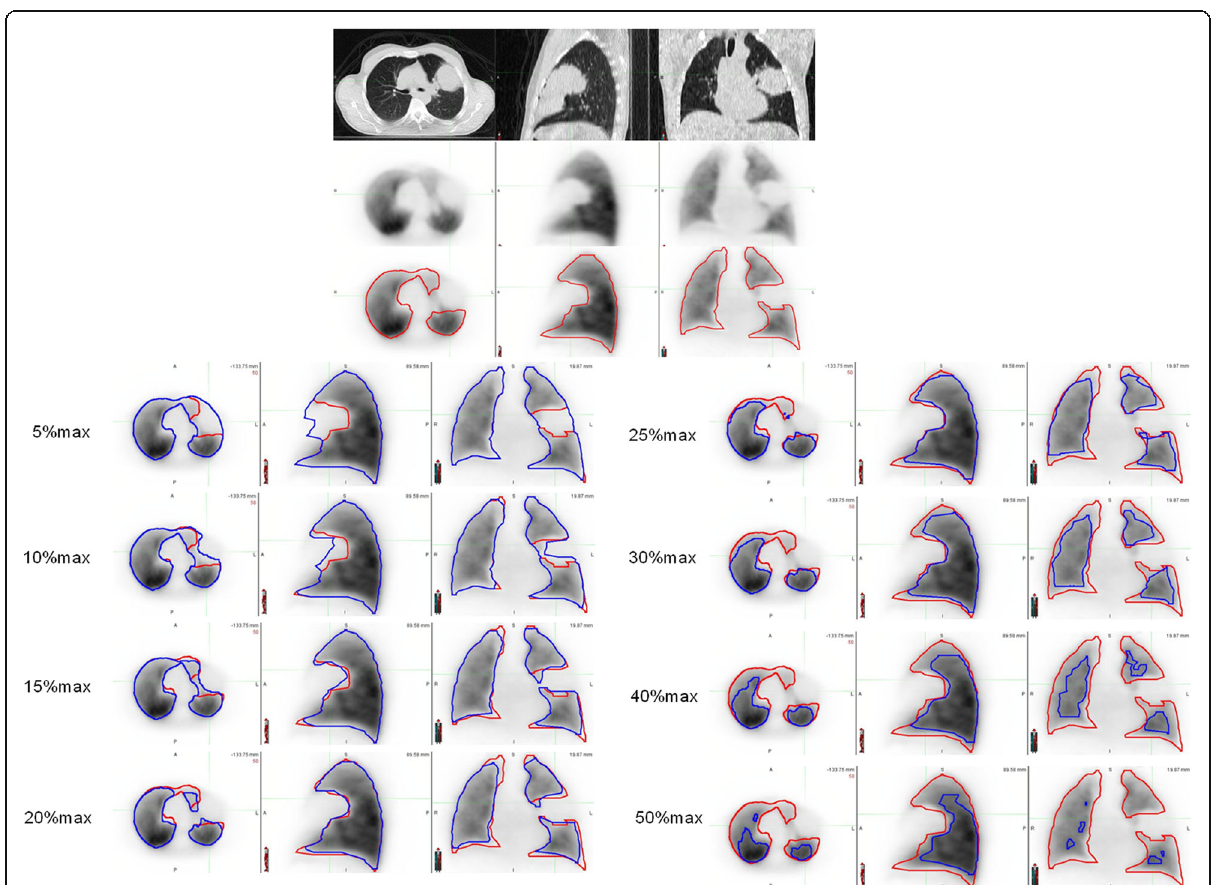
Fig. 1 Example of functional perfusion volume delineation. Visually defined manual contour is displayed in red. Automatic contours obtained by applying a cutoff value expressed as a percentage of the maximal value are displayed in